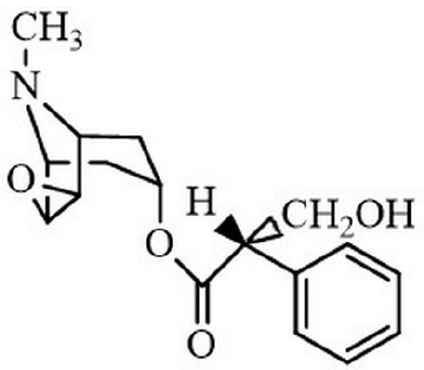
Figure 3. Chemical structure of Scopolamine.